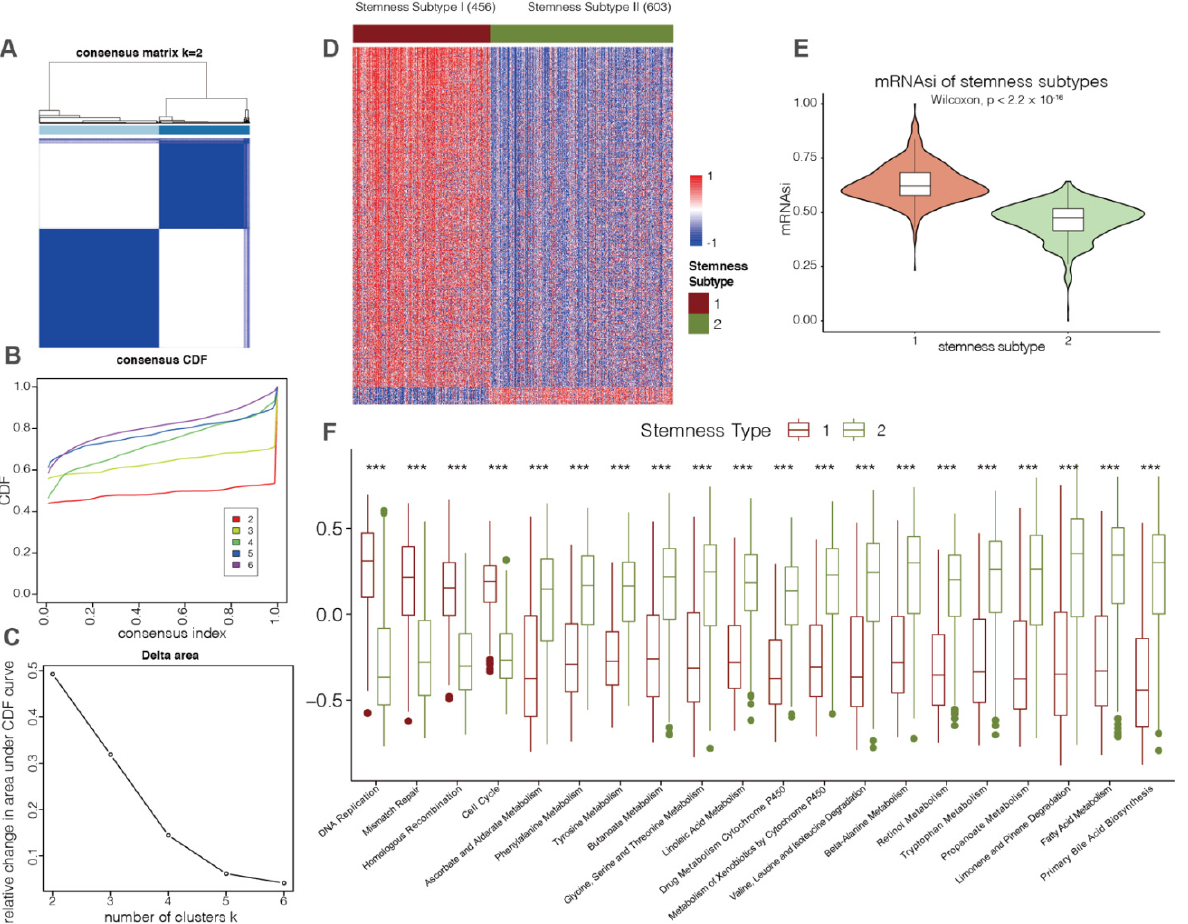
Figure 5 . Identification of two HCC stemness subtypes with distinct functional annotations. ( A – C ) Consensus clustering was conducted to classify HCC stemness subtypes. Consensus clustering matrix ( A ), cumulative distribution function ( C – F ) curves ( B ) and the relative change in the area under the CDF curve ( C ) from k = 2 to 6 was used to determine the optimal cluster number as 2. ( D ) Heatmap showing the expression levels of mRNAsi-related genes between the two HCC stemness subtypes. The color red represents genes that were positively correlated with mRNAsi, and the color blue represents genes that were negatively correlated with mRNAsi. ( E ) Violin plots of the mRNAsi of HCC patients classified by HCC stemness subtypes. ( F ) Boxplots illustrating the KEGG pathways with significantly differential enrichment scores, which were evaluated by GSVA analysis between HCC stemness subtypes (***, p ≤ 0.001).